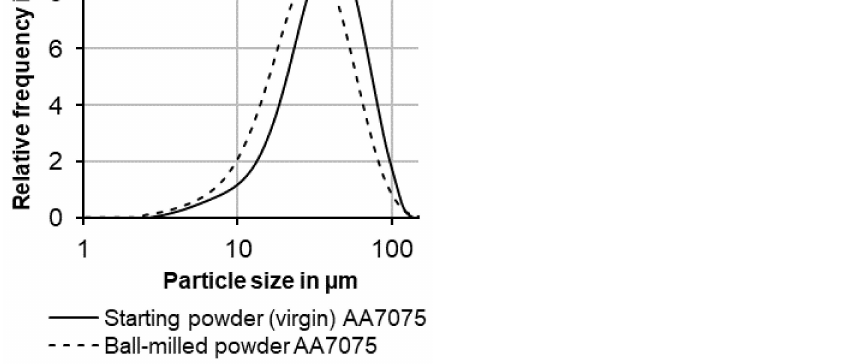
Figure 1. Powder particle size distribution before and after the ball milling process (without TiC